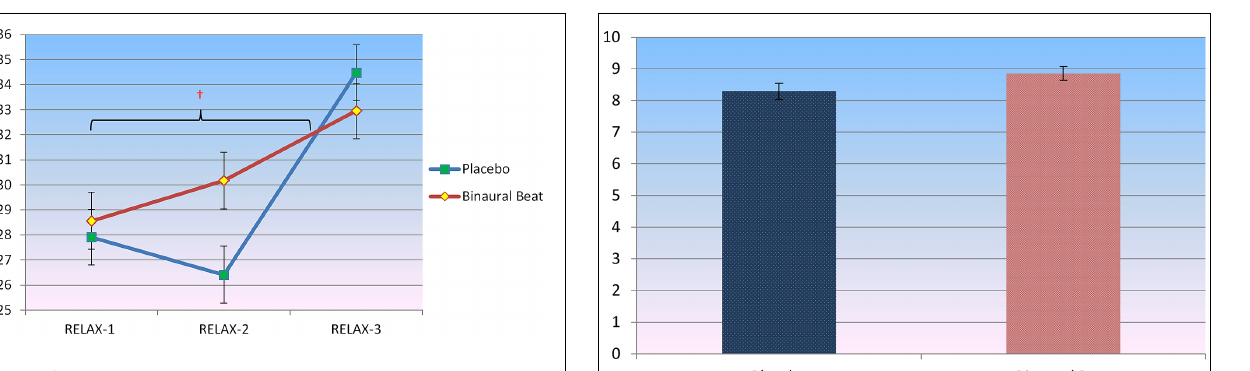
FIGURE 4 | Differences in the trajectory of high-frequency (HF) power (representing parasympathetic influence) over the course of relaxation between binaural-beat and placebo conditions. Error bars represent ± 1 SE of the marginal mean. † Simple main effect ofTime significant at p < 0.05 (for binaural-beat condition only).